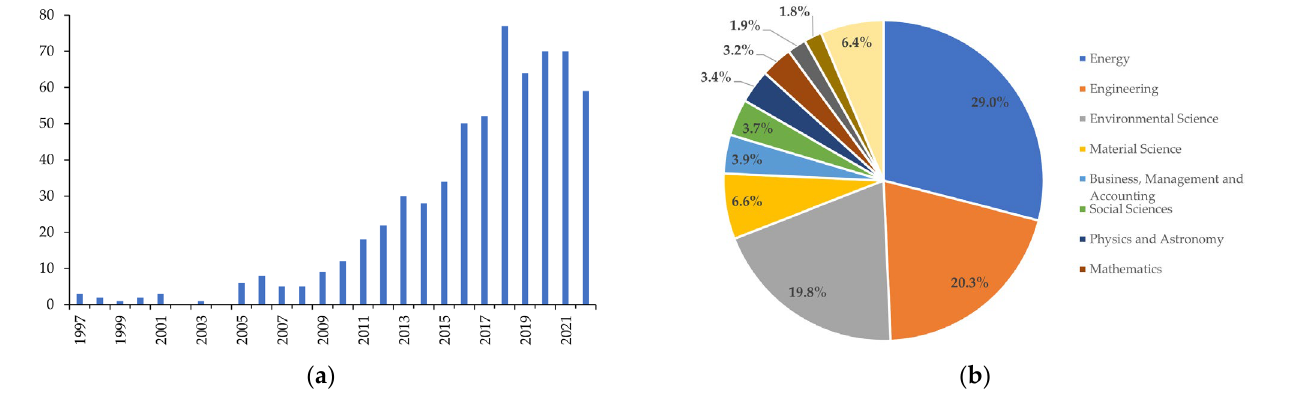
Figure 1. Published work in environmental impacts for PV systems. ( a ) Documents per year, and ( b ) documents per subject area. Source: [85].